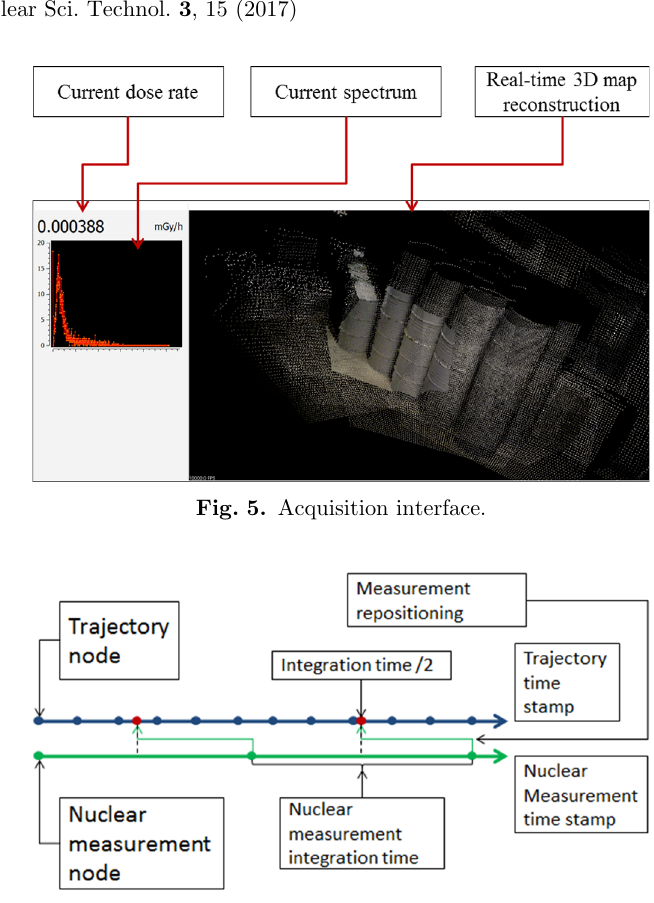
Fig. 6. Nuclear measurements